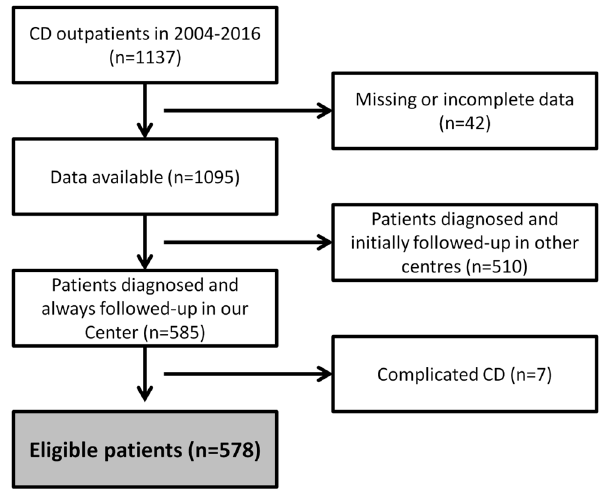
Figure 1. Patient